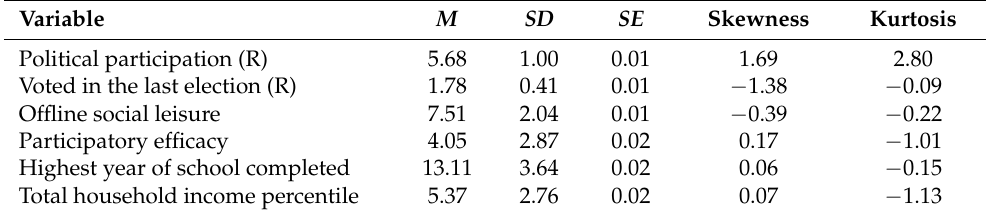
Table A4. Descriptive Statistics ( n =